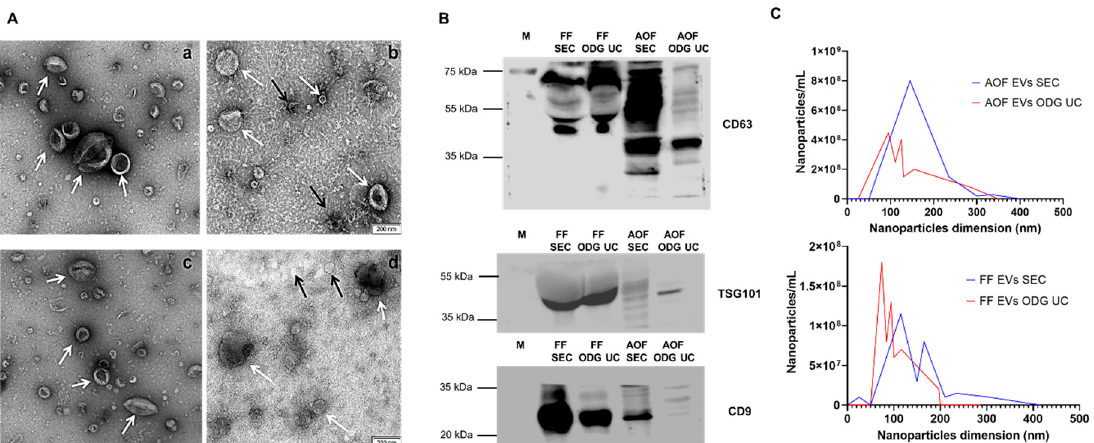
Figure 1. Characterization of extracellular vesicles (EVs) isolated from follicular fluid (FF) and ampullary oviductal fluid (AOF) by two different EV isolation methods: OptiPrep TM density gradient ultracentrifugation (ODG UC) and single-step size exclusion chromatography (SEC) (qEV IZON™ single column)). ( A ) Transmission electron microscopy showing morphological structures of EVs (white arrows) and protein aggregates (black arrows) from AOF and FF by the ODG UC (a,c) and SEC (b,d) isolation methods, with sizes ranging from 40 nm to 400 nm in diameter (scale bar: 200 nm). ( B ) Western blotting analysis showed the presence of EV-associated proteins CD63 (42 kDa), CD9 (25 kDa), and TSG101 (42 kDa) in AOF and FF by both isolation protocols (ODG UC and SEC). ( C ) Analysis of the particle size (nm) distribution of EVs isolated from AOF and FF by ODG UC (Red) and SEC (Blue) is determined by a nanoparticle tracking analysis (NTA). Particles ranged between 50 to 400 nm. Abbreviations: M = marker (protein ladder).